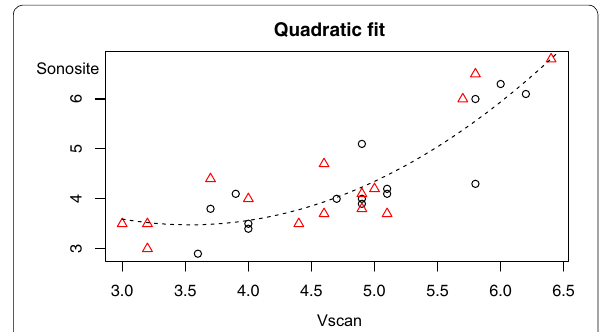
Fig. 4 Quadratic regression model comparing VScan to SonoSite